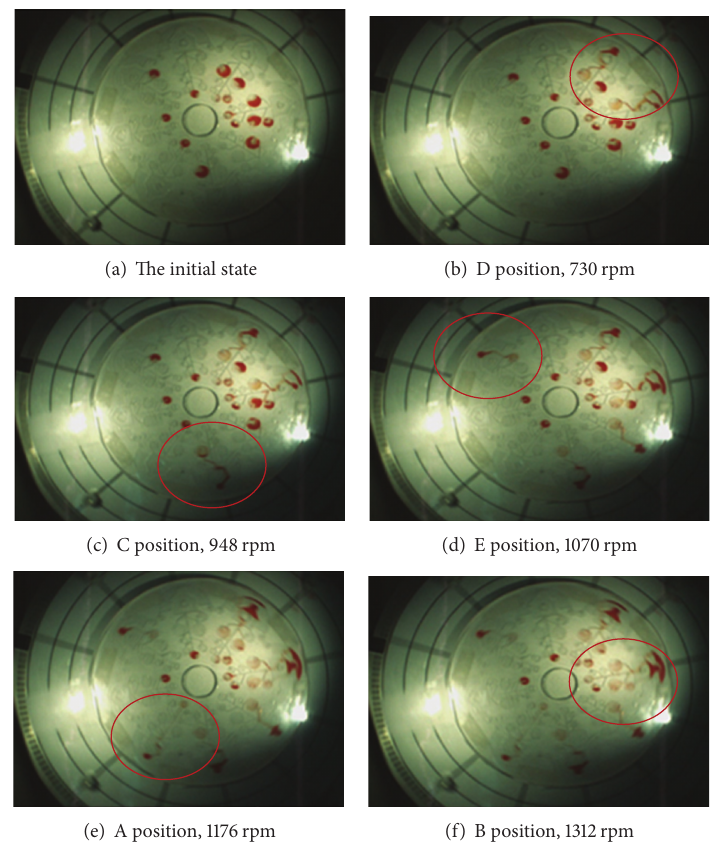
Figure 8: Flowing sequence controlled by the spinning speed.